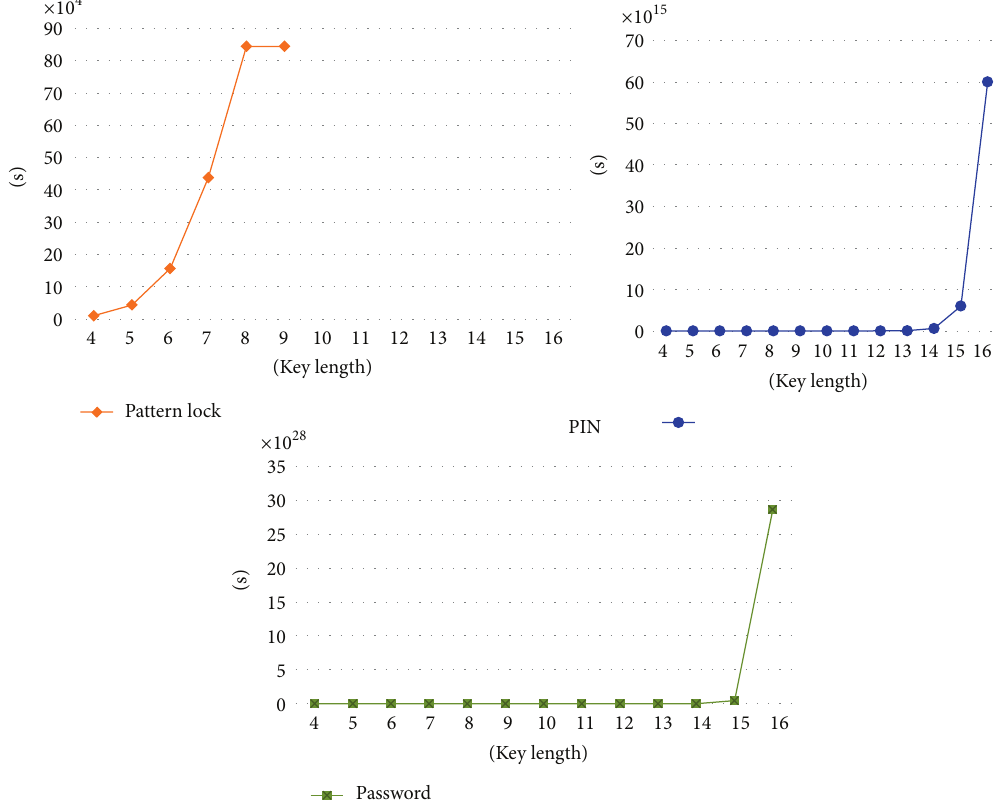
Figure 7: Timing for all possibility patterns depending on pattern